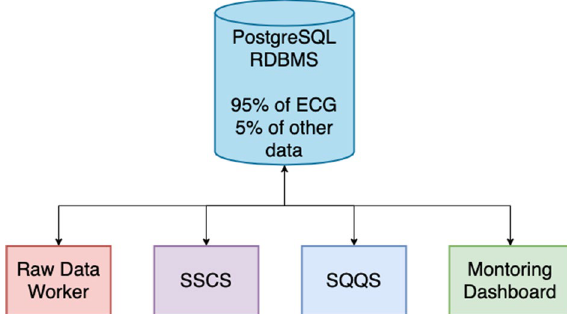
Fig. 11 The traditional system with a full